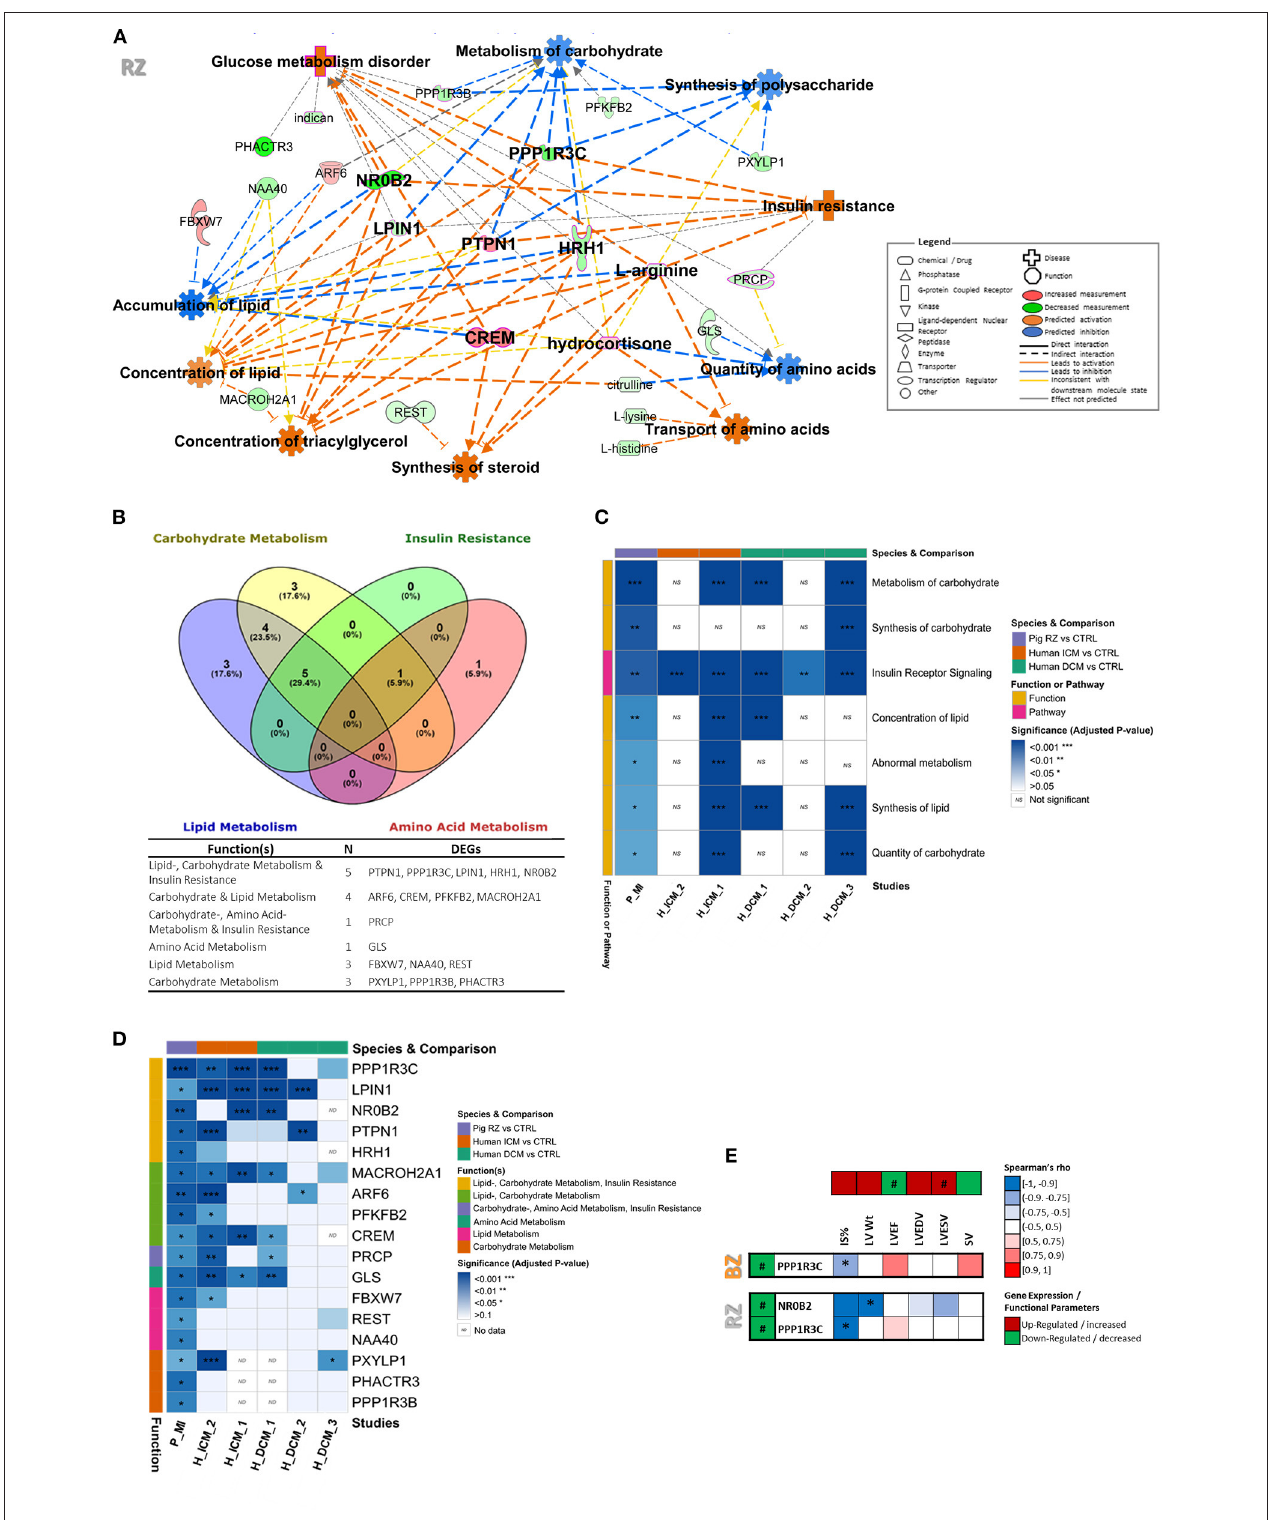
FIGURE 4 | Identification of targets putatively involved in metabolic dysregulation in chronic HF and validation using datasets from human ICM and DCM patients. (A) Metabolic function network analysis performed in IPA for RZ using both transcriptomic and metabolomic datasets. Only the significantly dysregulated genes (FC ≥ |1.5| and FDR < 0.05) and metabolites (VIP > 1.2 and t -test p -value < 0.05) were included in the analysis. The gene or metabolite is referred to as nodes and the intensity of